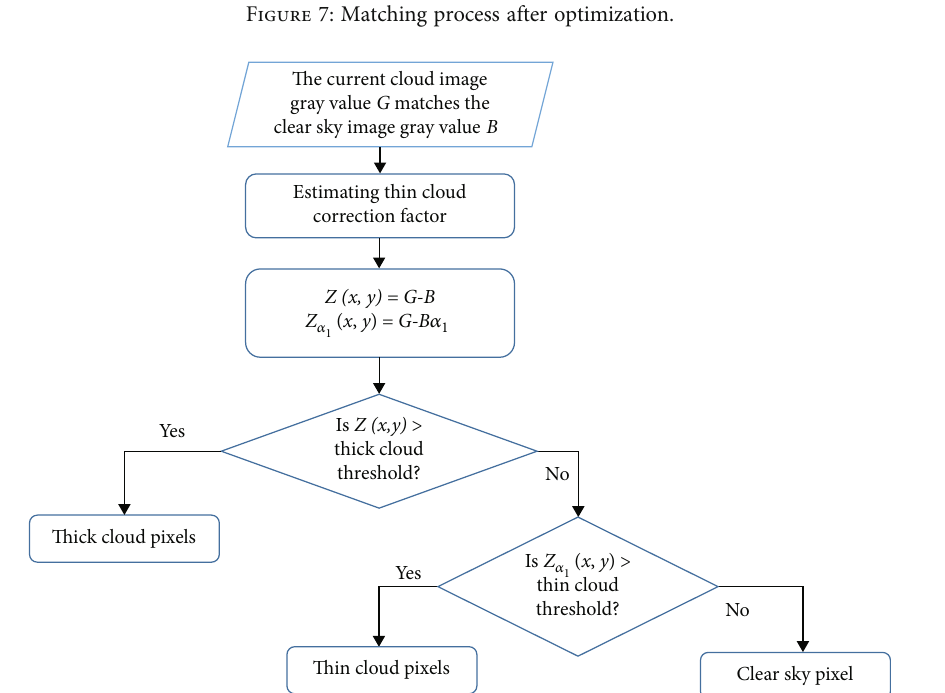
Figure 8: Improved threshold segmentation algorithm fl